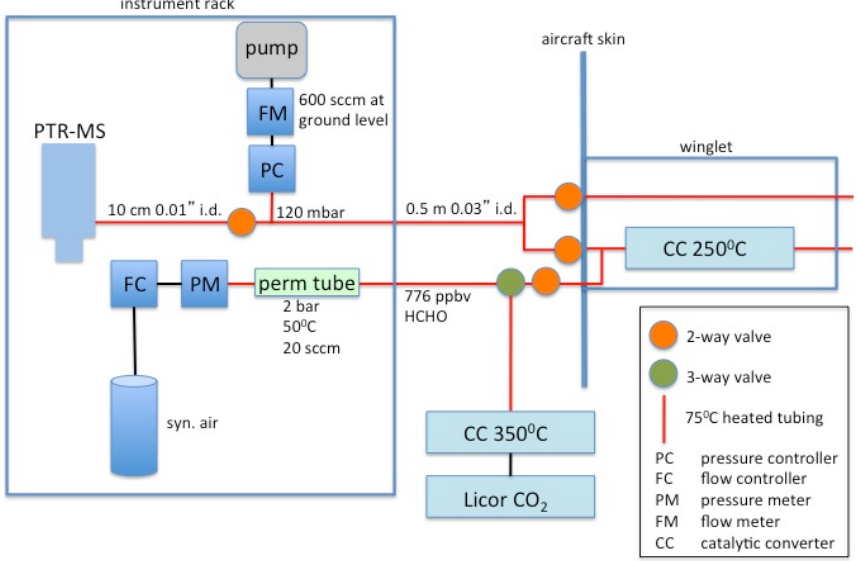
Fig. 2. Inlet and calibration system used during the CalNex 2010 campaign on the NOAA WP-3 aircraft.